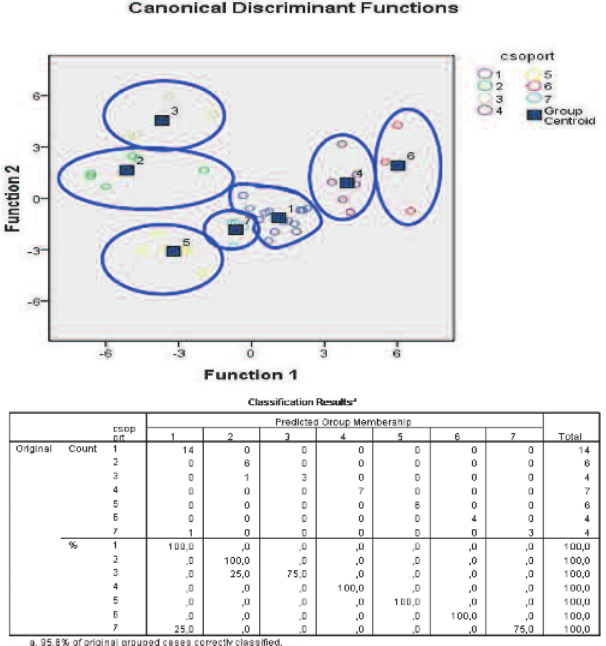
Figure 5. Discriminant analysis of apple samples (the goodness of PCA